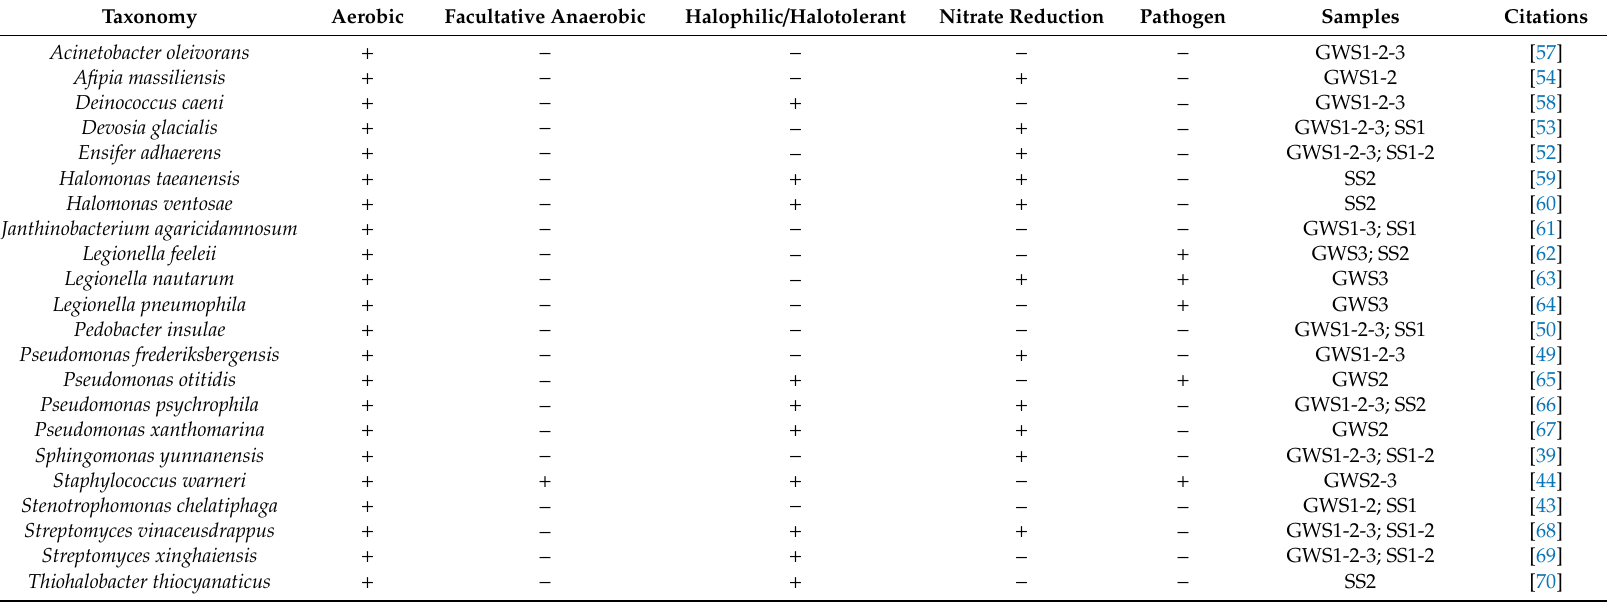
Table 2. Physiological and biochemical characteristics of some of the species found in groundwater and soil samples after the 16S rRNA gene partial sequencing. ( − negative; +